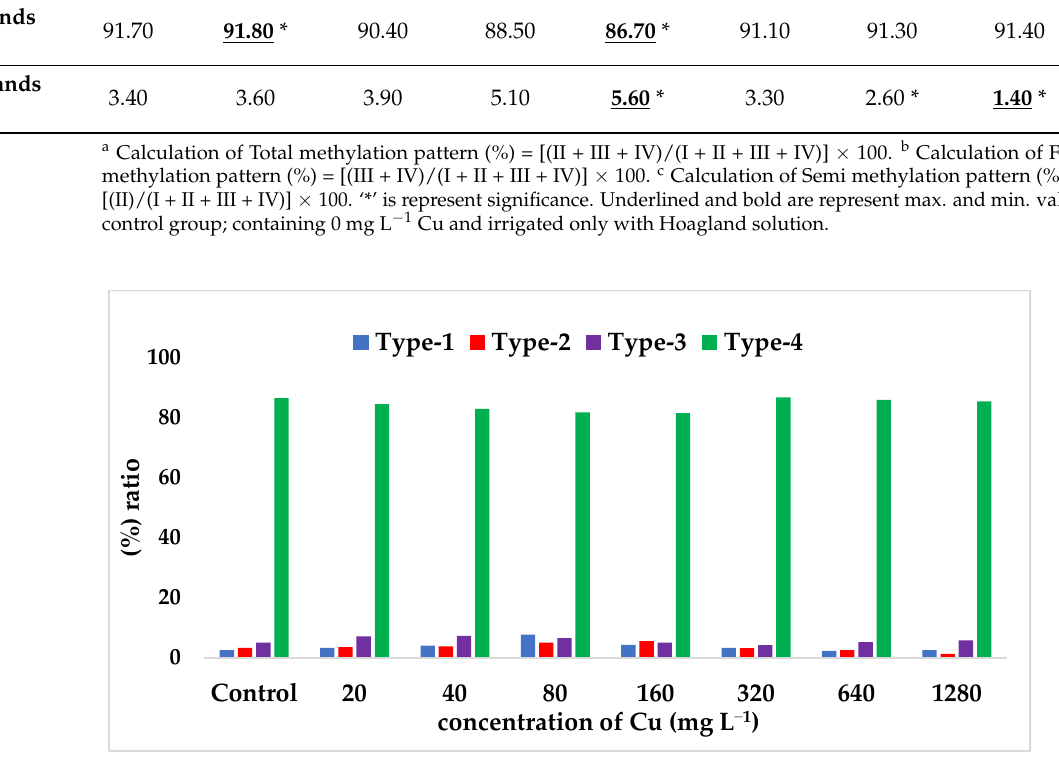
Figure 3. The average rates of methylation patterns based on CRED-RA data analysis in the root tissues of safflower seedlings after exposure to increasing Cu concentrations (20–1280 mg L − 1 CuSO 4 ·5H 2 O) for 21 days, compared to the control group (containing 0 mg L − 1 Cu and irrigated only with Hoagland solution). 4. Discussion Heavy metal pollution is a prominent topic in the field of environmental pollution research. In high concentrations, heavy metals can have a devastating impact on a wide range of living organisms, making it a critical issue that needs to be addressed. One of the most significant consequences of heavy metal contamination is its ability to inhibit plant growth [22–25]. The excessive accumulation of heavy metals in plant tissues leads to neg- ative impacts on seed germination and root and stem growth. Several studies have estab- lished the toxicity caused by heavy metals in high concentrations, acting as catalysts in